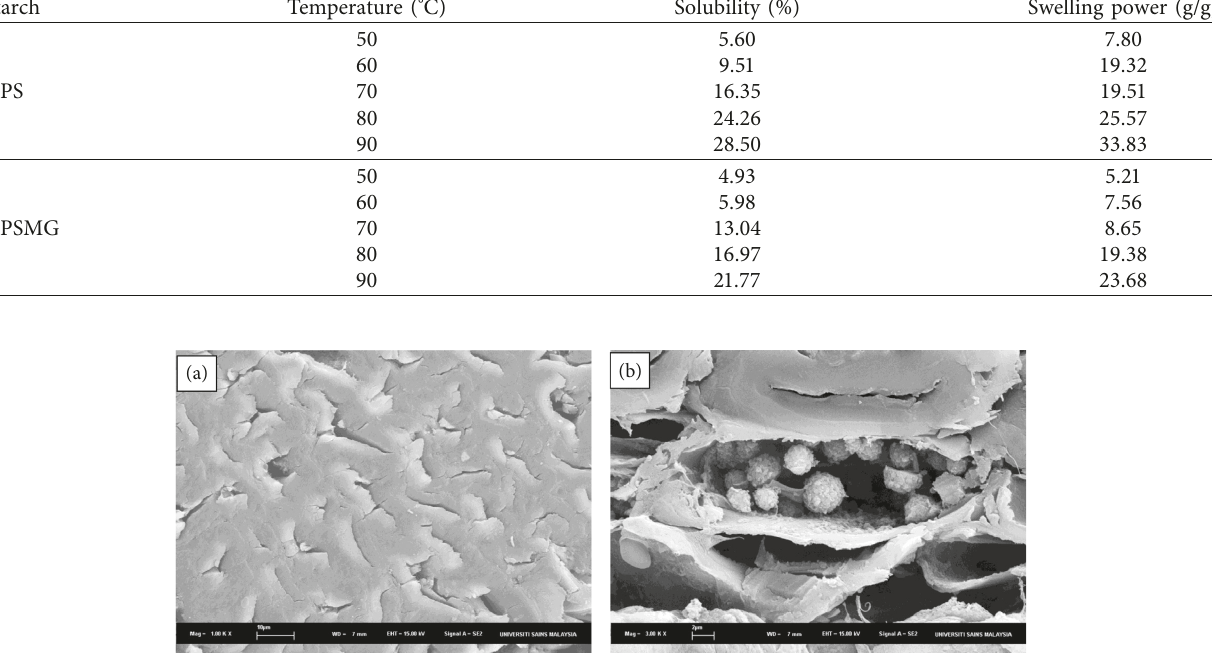
Table 1: Solubility and swelling power of OPS and OPSMG.